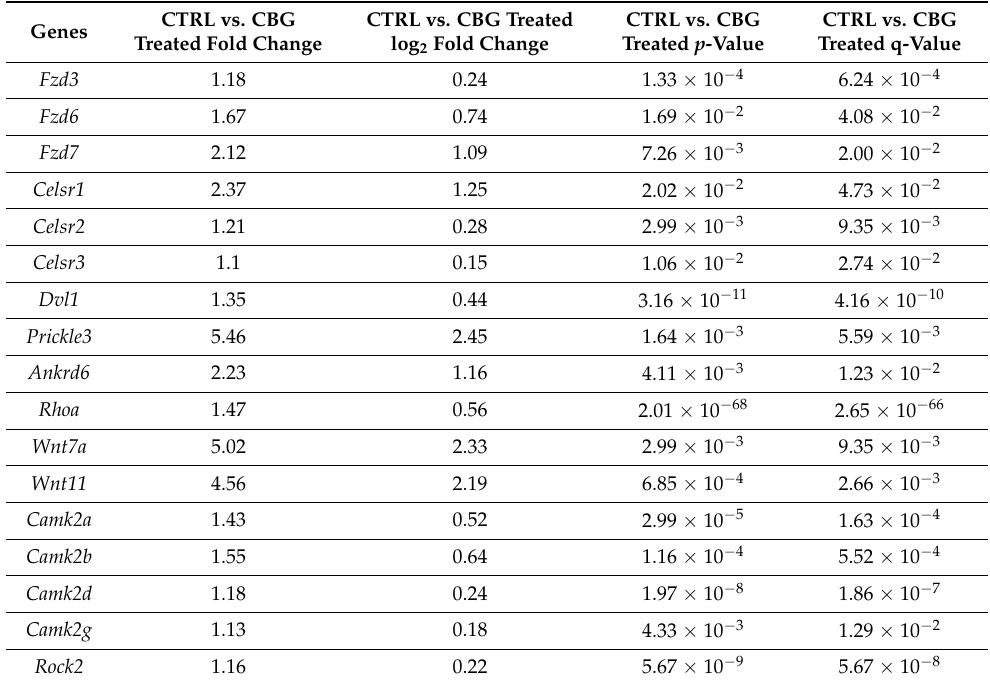
Table 2. Differentially expressed genes involved in WNT/planar cell polarity (PCP) signaling.